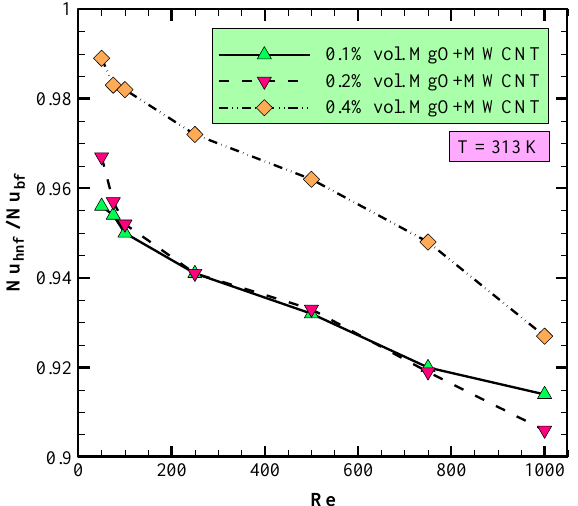
Figure 10. Effects of HNF with different VF on average Nu ratio for different Re and inlet temperature T = 313 K.